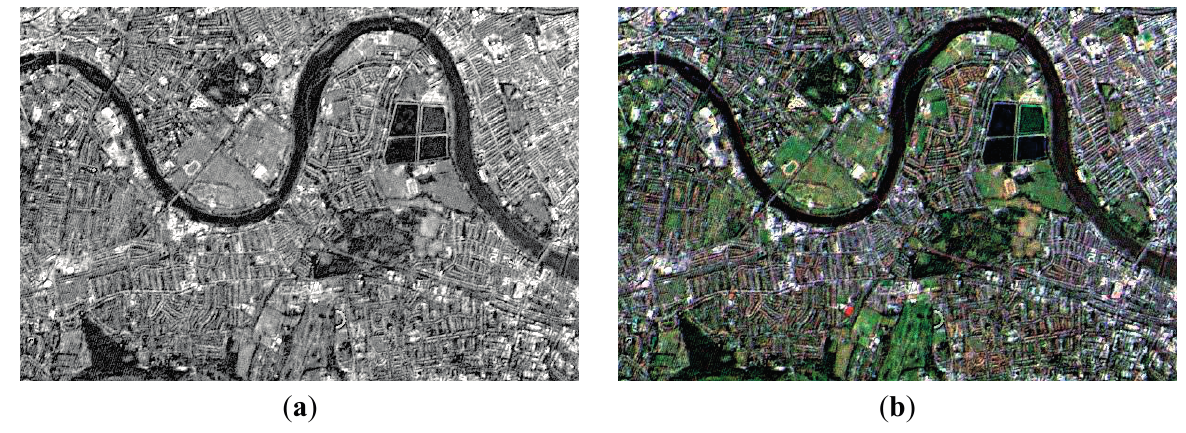
Figure 7. ( a ) The new V band image, enhanced by HP from step 3 plus V band from step 1. ( b ) Final fused